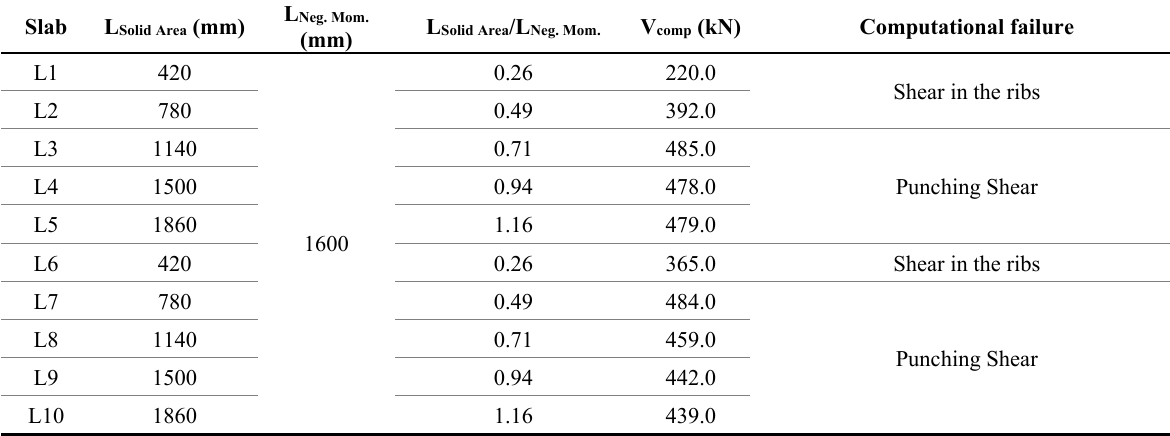
Table 3. Computational results and solid areas dimensions Slab L Solid Area